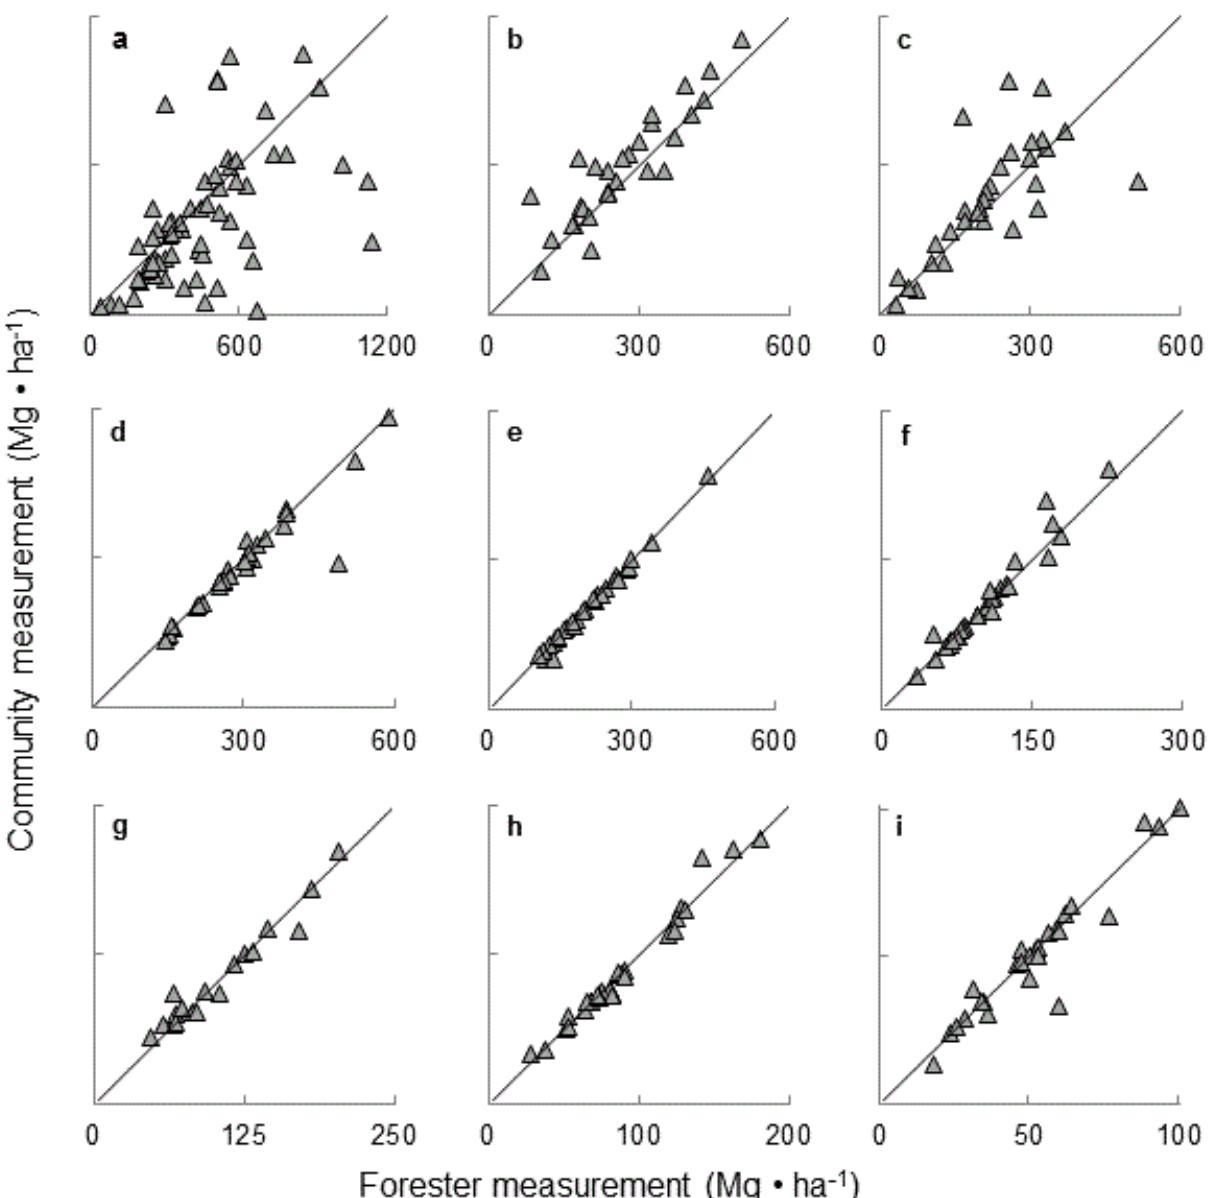
Fig. 1 . Relationship between the aboveground woody biomass recorded by community members and forester plot-based aboveground biomass measurement in lowland dipterocarp forest in Batu Majang, Indonesia (a), mountain rain forest in Manlin, China (b–c), evergreen monsoon forest in Sakok, Laos (d–e), and Diem (f) and Moi (g–i), Vietnam (with same units on y-axes as on x-axes and y = x lines; n = 289 permanent plots). Each point in the graphs represents one census of aboveground woody biomass in a permanent plot by community members (y-axes) and foresters